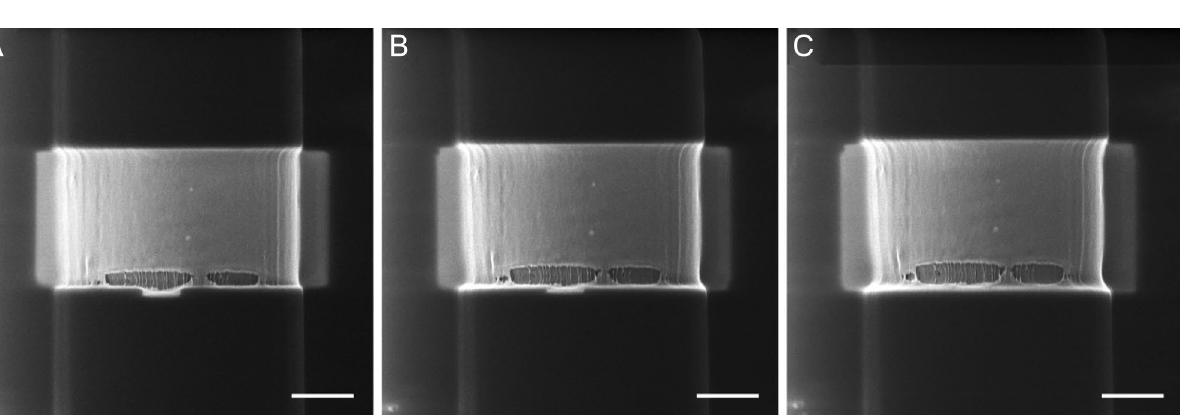
Figure 2. Scanning HIM images of a MAS fibre where the top layers are etched away perpendicularly to the fibre’s long axis using, He ion sputtering. ( A ) A spider silk fibre before etching in the marked area. ( B – D ) The top layers of the fibre from ( A ) are gradually being etched and fibrils within the fibre start to appear. VD = 8.5 mm, FoV = 6.5 µm and beam current = 0.284 pA. Scalebar is 2 µm. ( E ) Schematic representation of how fibrils appear in HIM.